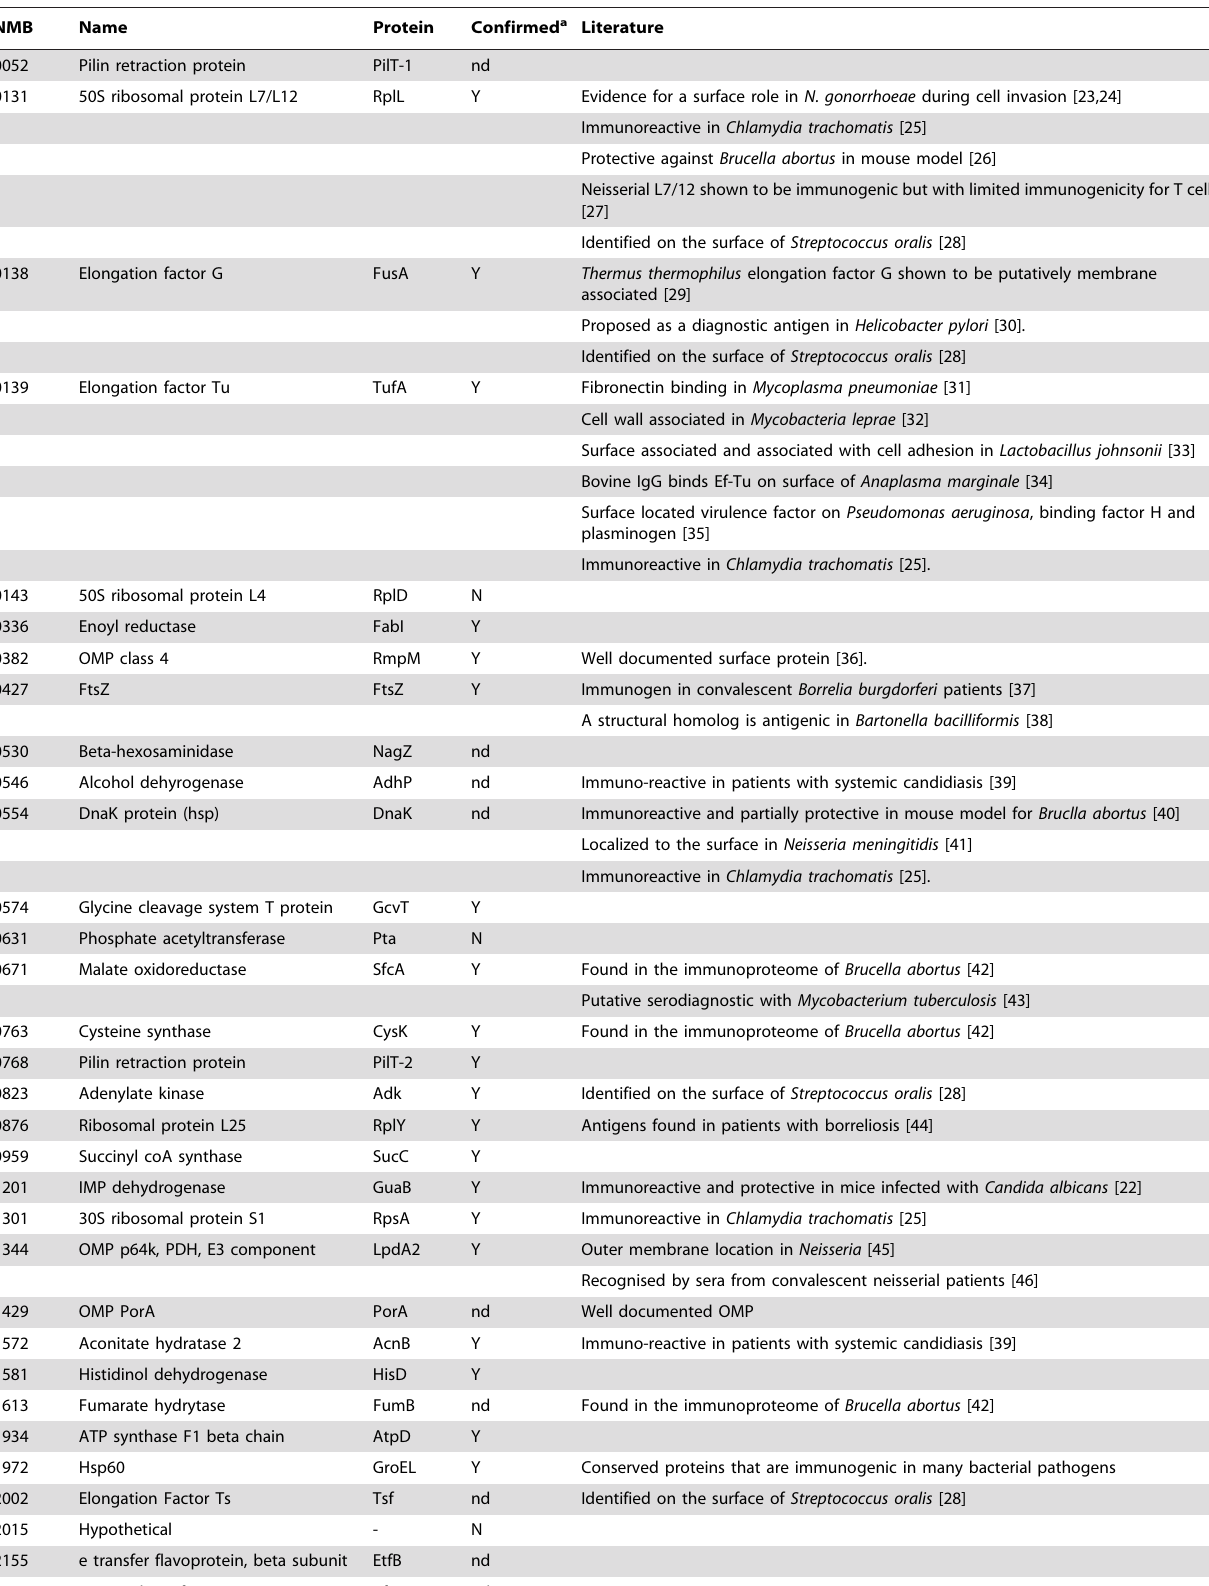
Table 3. Proteins that bound IgG from one or more of the patients sera.